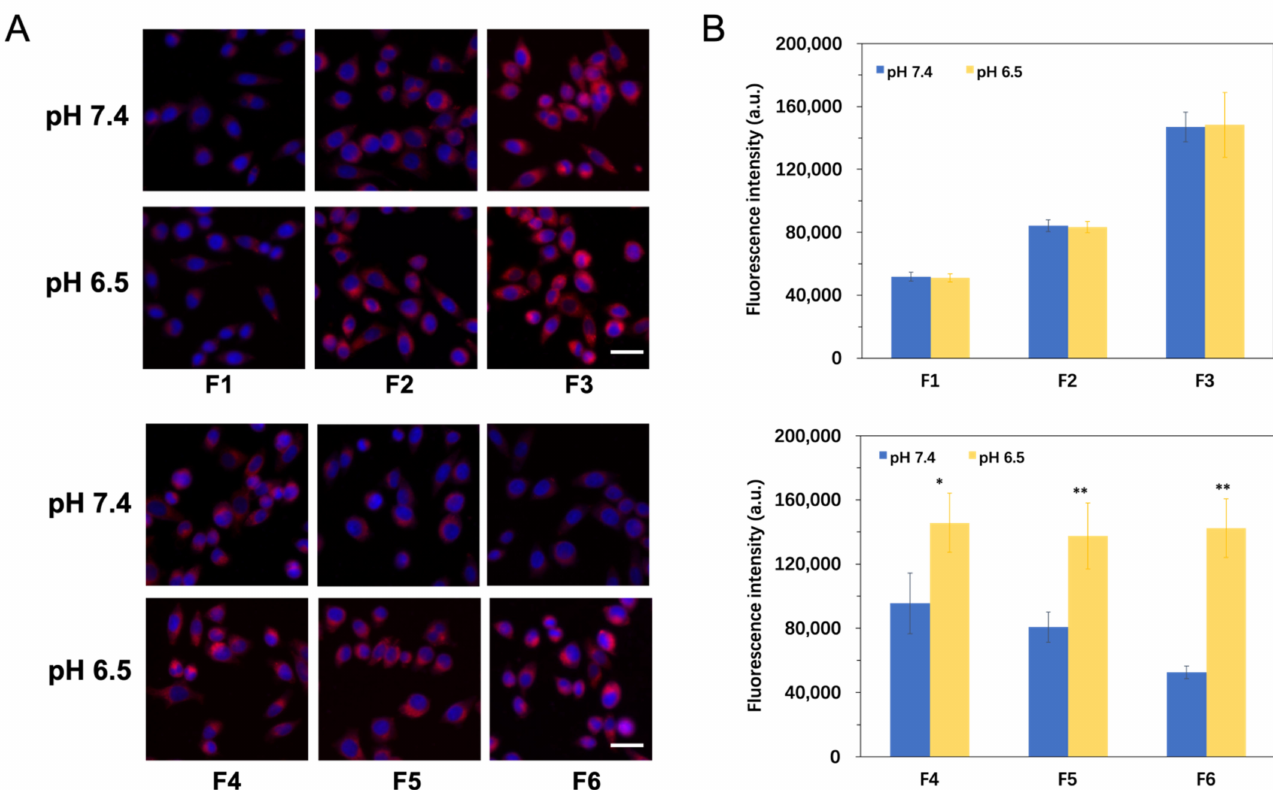
Figure 5. In vitro cellular uptake studies of Cy5.5-labeled nanoparticles with different concentrations of TAT and PGlu- PEG in Hep G2 cells for 4 h. ( A ) Representative images depicting cellular uptake of different formulations with various concentrations of TAT and PGlu-PEG coating (F1–F6) at pH 7.4 and pH 6.5; Blue: DAPI for nuclei, Red: Cy5.5. Scale bar represents 20 µ m. ( B ) Quantitative analysis of the fluorescence signals of Cy5.5 at pH 7.4 and pH 6.5 ( n = 3). * p < 0.05; ** p < 0.01. F1 represents N-NPs (without TAT or PGlu-PEG modifications); F2 and F3 represent TAT-NPs modified with different TAT concentrations (0.6% for F2 and 1.2% for F3) but without PGlu-PEG modification; F4, F5, and F6 represent PGlu-PEG/TAT-NPs thta were modified with the same TAT concentration (1.2%) but different PGlu-PEG concentrations (2% for F4, 5% for F5, and 10% for